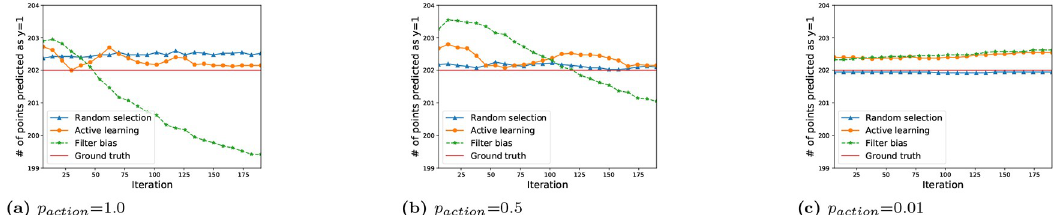
Fig 10. Effect of Human action on the boundary learned during the iterations. The y-axis is the number of testing points which are predicted to be relevant. We can see that for both random selection and active learning bias, the number of points predicted as relevant converges to the ground truth boundary when there is a high probability of human action. On the other hand, filter bias tends to diverge from the ground truth boundary in the presence of high human action probability. With p action = 0.01, there are no obvious trends for all three algorithmic bias forms.